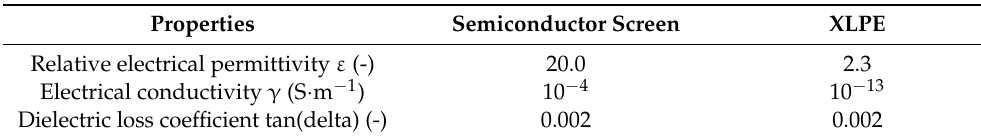
Table 2. Properties of semiconductor screen and pure XLPE used to calculate the electric field distribution and dielectric losses in high-voltage cables [1,4–6,22–24]. Properties Semiconductor Screen XLPE Relative electrical permittivity ε (-) 20.0 2.3 Electrical conductivity γ (S · m − 1 ) 10 − 4 Dielectric loss coefficient tan(delta) (-)